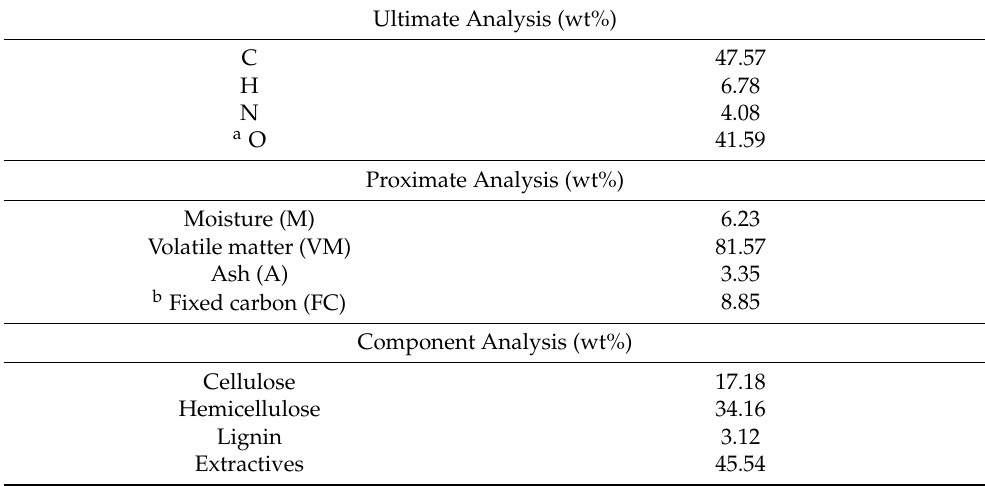
Table 1. Results of ultimate, proximate, and component analysis of BSG in an air-dry